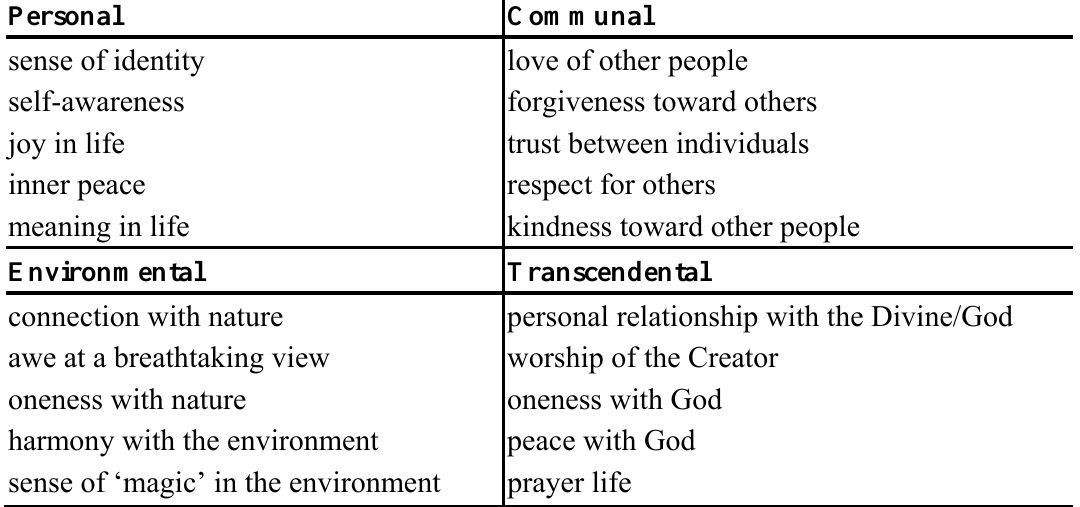
Table 1. Items comprising four domains of spiritual well-being in